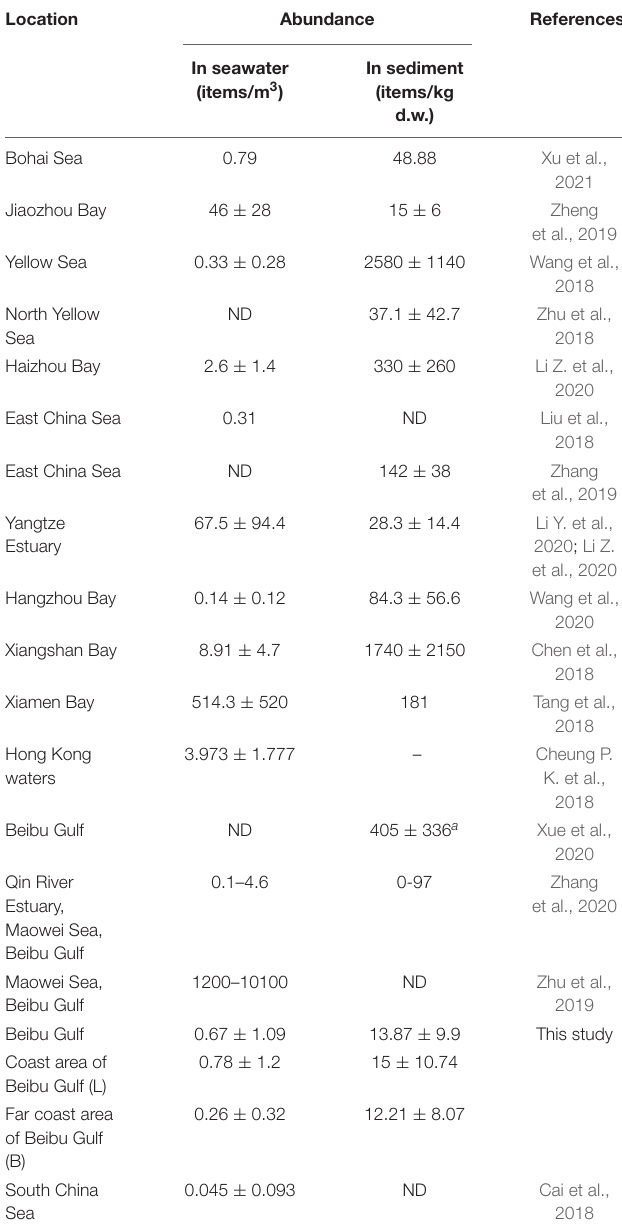
TABLE 1 | Summary of microplastic abundances reported in surface water and sediment from various sea areas in China (data published within the last 3 years, revised from Wang et al.,